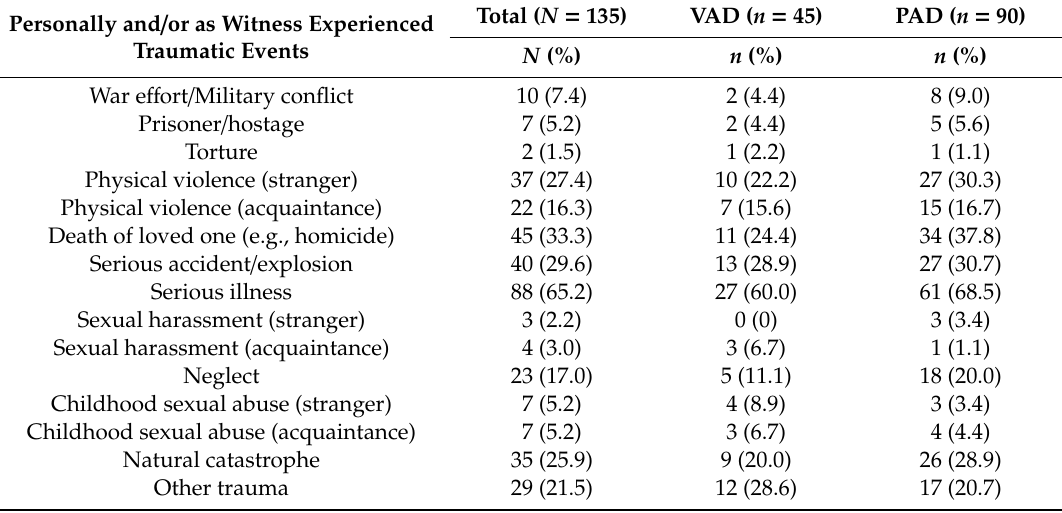
Table 4. Lifetime prevalence of traumatic events of the study sample.